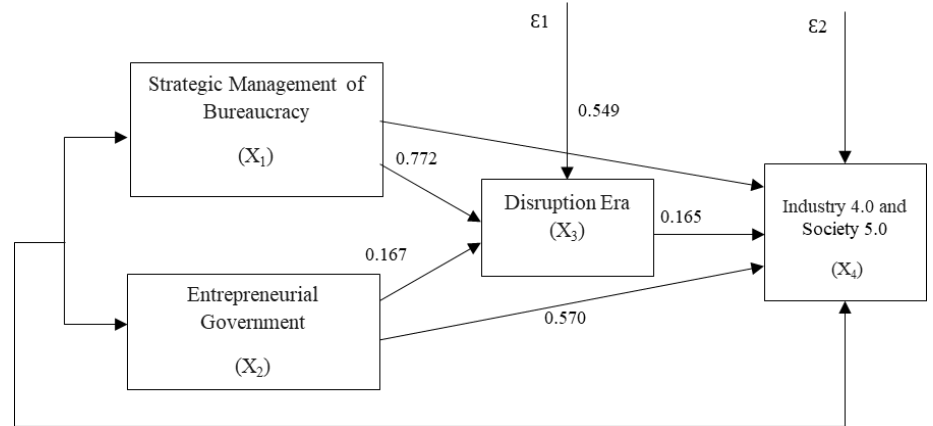
Figure 1. Design Diagram in this study.